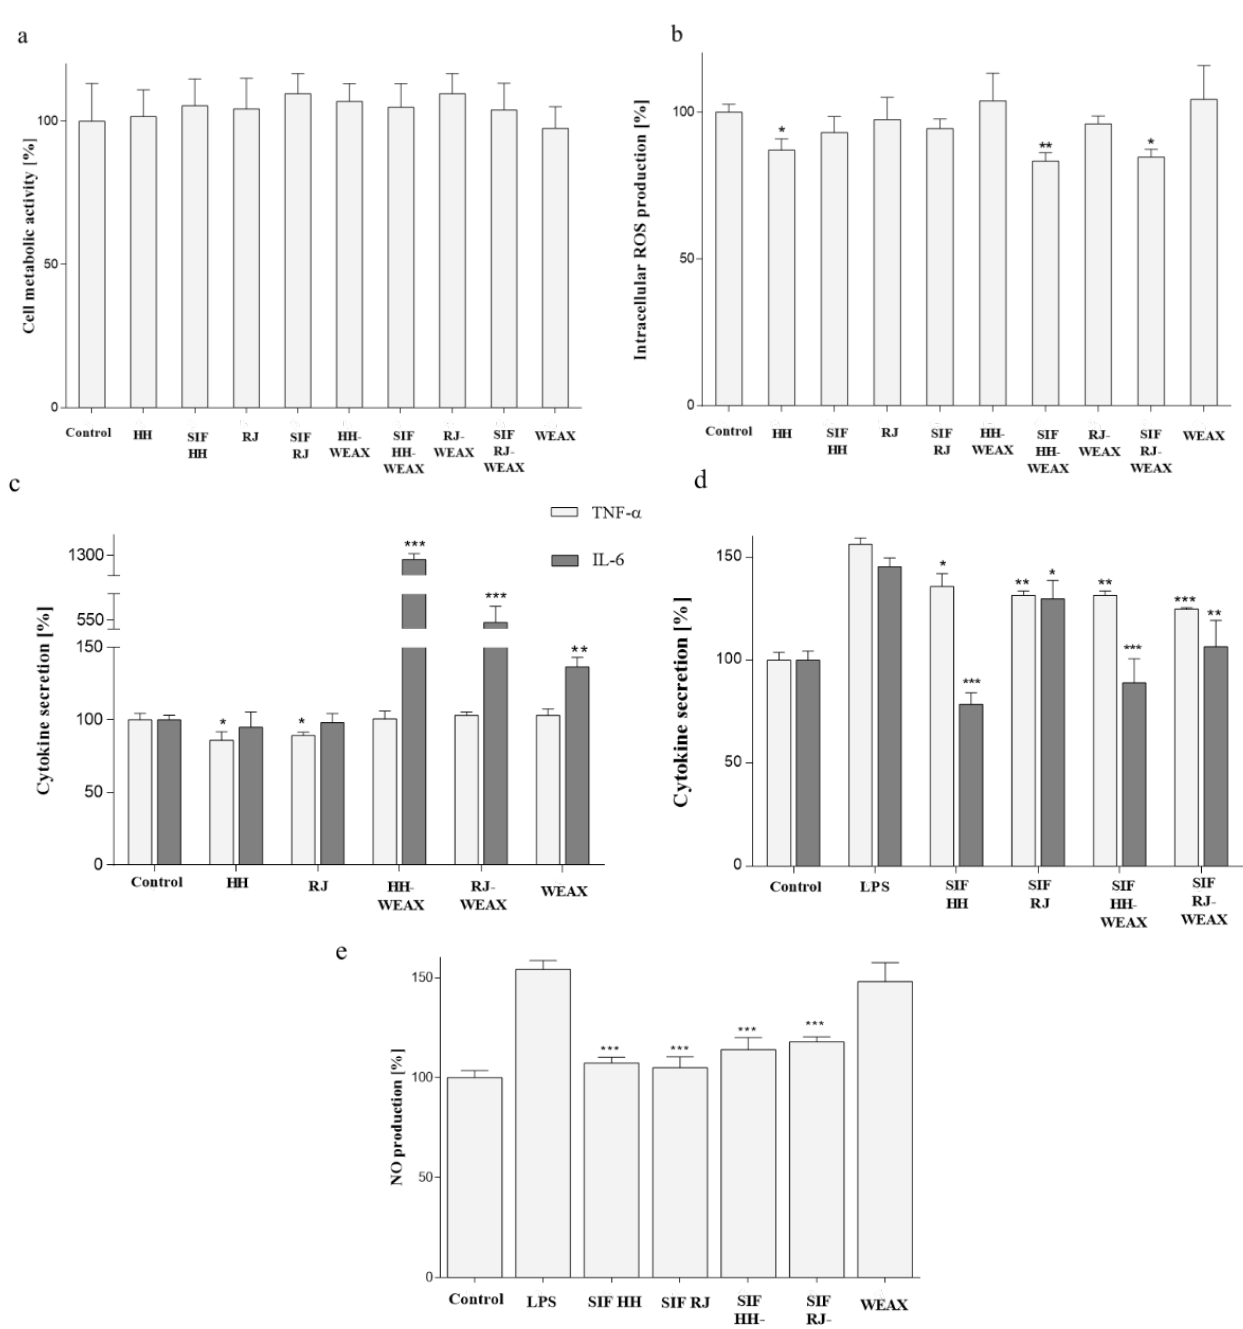
Figure 6. The influence of honey, royal jelly, encapsulated bee products and WEAX biopolymers at 0.15 mg mL − 1 concentration on RAW 264.7 cells’ ( a ) metabolic activity determined with PrestoBlue assay; ( b ) intracellular ROS level determined with DCF assay; ( c ) IL-6 and TNF- α secretion deter- mined with ELISA assay without treatment with LPS and ( d ) in cells stimulated with LPS; ( e ) NO release in LPS-stimulated cells determined with Griess reagent after 24 h incubation. Small intestine fraction (SIF) samples treated with in vitro intestinal digestion. Each value on the graphs represents the mean value ± SEM, n ≥ 3. Significance of differences between means * p < 0.05, ** p < 0.01, *** p < 0.001 versus control cells ( a – c ) or LPS-stimulated cells ( d , e ). As elevated concentration of intracellular reactive oxygen species, also as a result of a reaction with nitric oxide, can lead to the formation of harmful peroxynitrite,